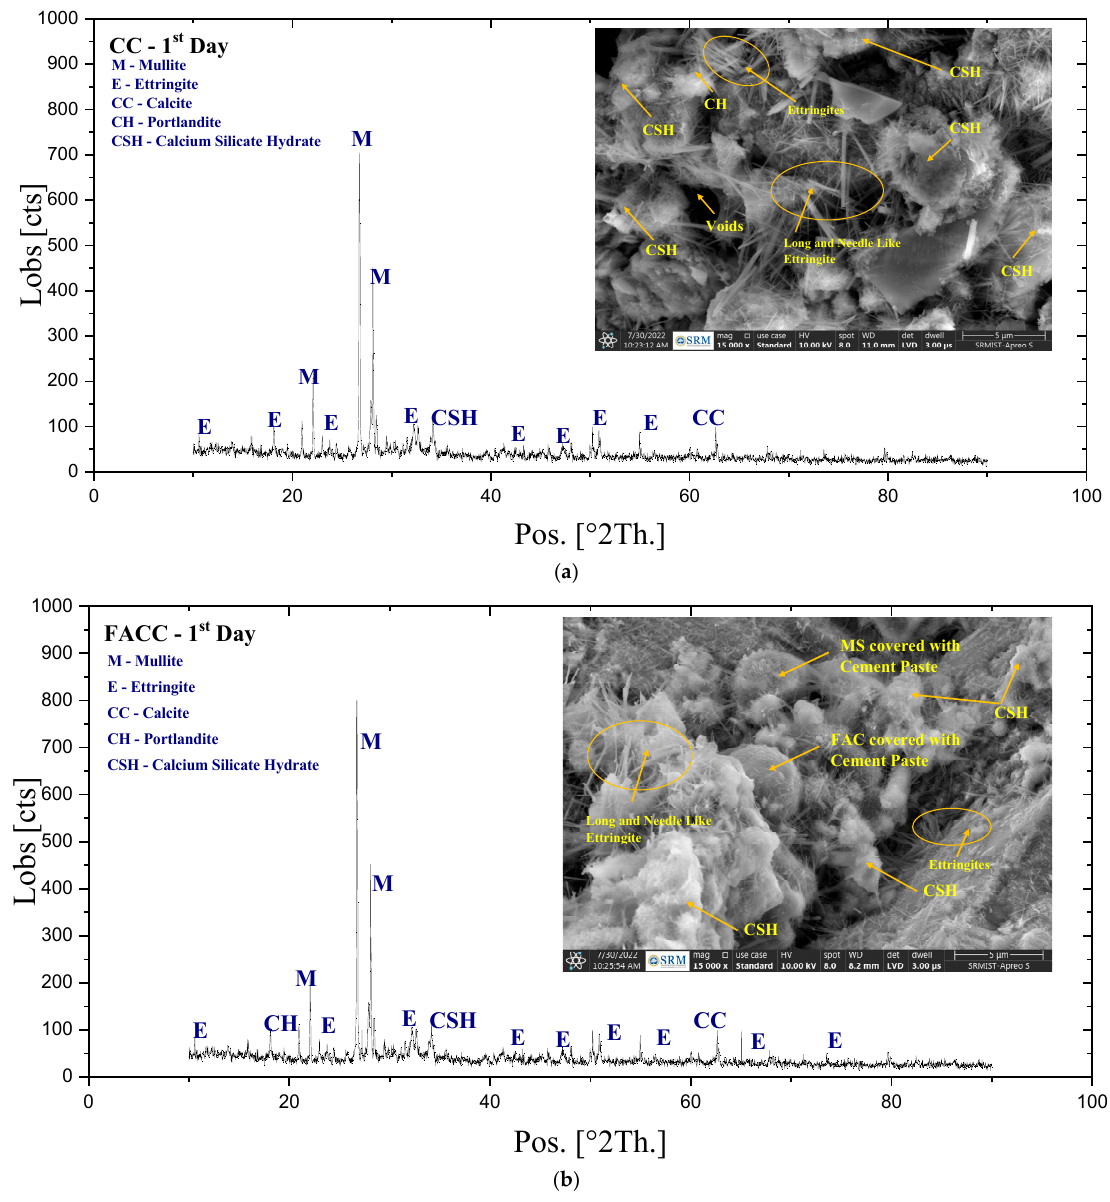
Figure 10. XRD and SEM ( a ) CC ( b ) FACC on the First Day of Testing.